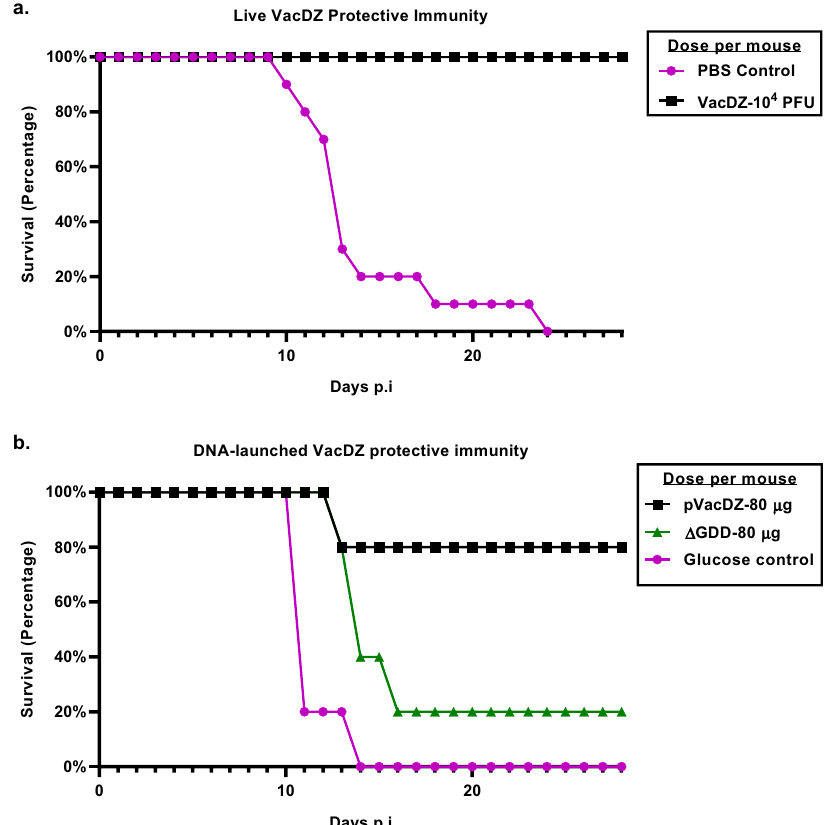
Fig. 6 Survival curve for protective immunity studies in AG129 mice. 5-8 weeks old AG129 mice were inoculated intraperitoneally with the indicated vaccine or control. Four weeks after vaccination, they were challenged with a lethal dose of 10 5 PFU of ZIKV per mouse. The mice were then kept for four weeks and observed daily for clinical symptoms and killed when they reached a humane endpoint. a AG129 mice vaccinated with VacDZ (10,000 PFU per mouse, n = 11) or PBS vehicle control ( n = 10). b AG129 mice vaccinated with DNA-launched VacDZ (pVacDZ, 80 μ g of pVacDZ and 20 μ g of pTet-Off Advanced per mouse, n = 5), 5% glucose solution vehicle control (glucose, n = 5), or pVacDZ- Δ GDD replication defective mutant ( Δ GDD, 80 μ g of pVacDZ- Δ GDD and 20 µg of pTet-Off Advanced per mouse, n =